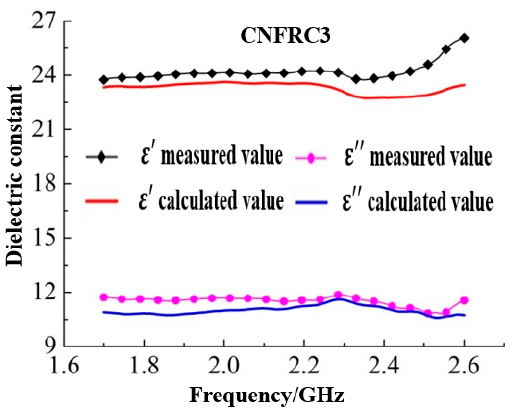
Figure 7. Results of dielectric constants calculated based on Brown model.